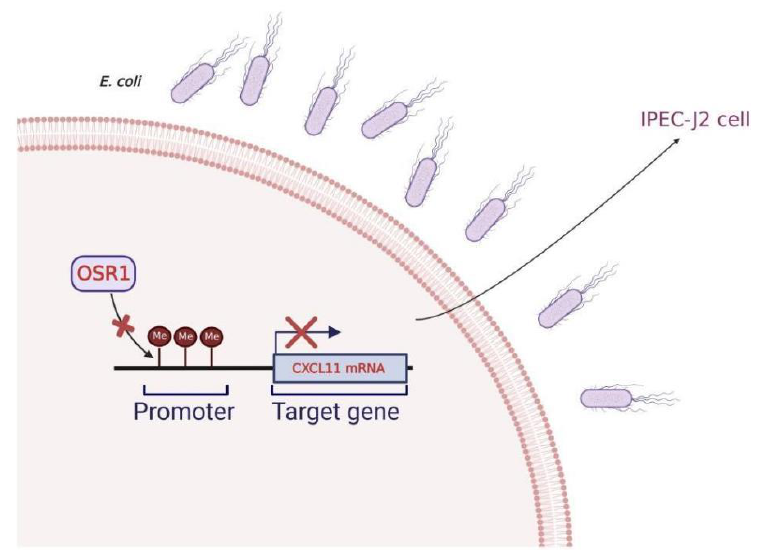
Figure 8. A working model summarizing the mechanism of the CXCL11 gene in regulating E. coli F18 susceptibility in IPEC-J2